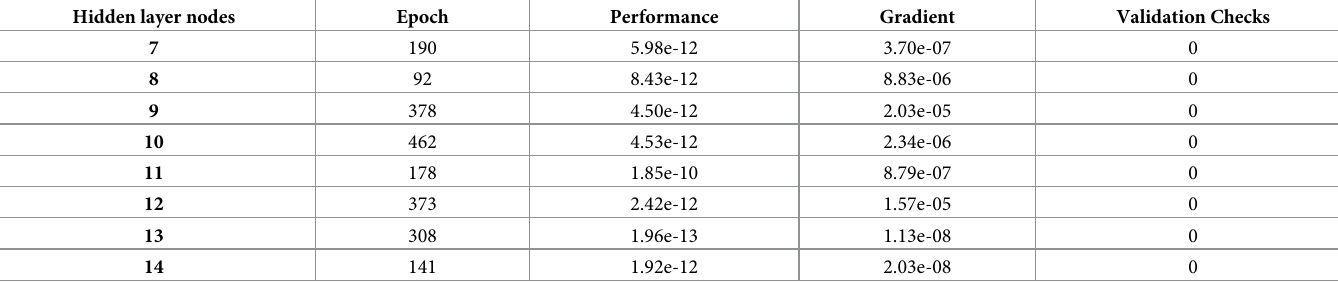
Table 4. Comparison of prediction with different hidden layer nodes (BR).